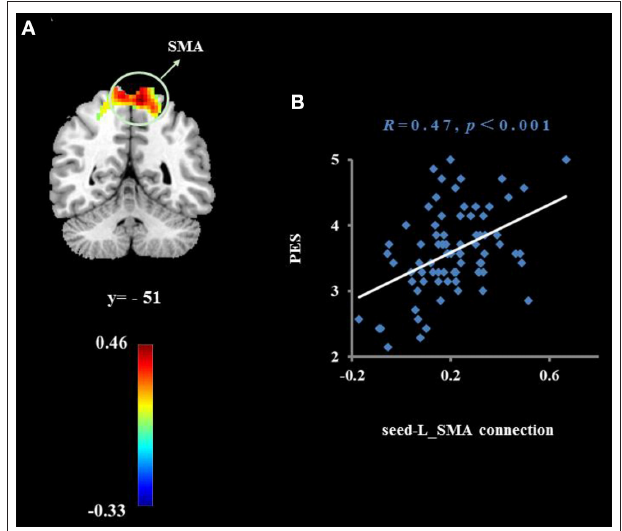
FIGURE 4 | Cluster whose functional connectivity strength with the right subgenual cingulate (seed) was significantly associated with the average score of PES (A) . The threshold of corrected cluster was set at P < 0.05 [single voxel P < 0.001, cluster size > 276 voxels, and 1000 iterations]. Color bars represent R-values. L = left, R = right. (B) indicates a significant correlation between the average score of PES and functional connectivity strength with the left supplementary motor area